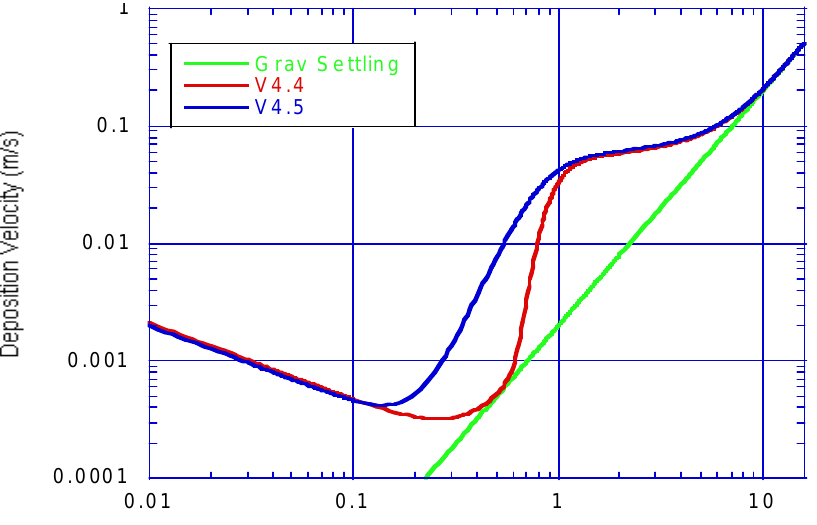
Figure 3. Modal integrated aerosol dry deposition velocity for CMAQv4.4 and CMAQv4.5 (see text for